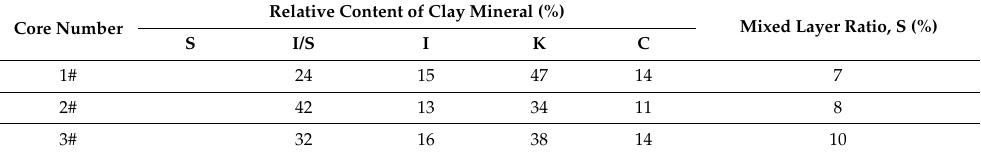
Table 3. Relative content of clay